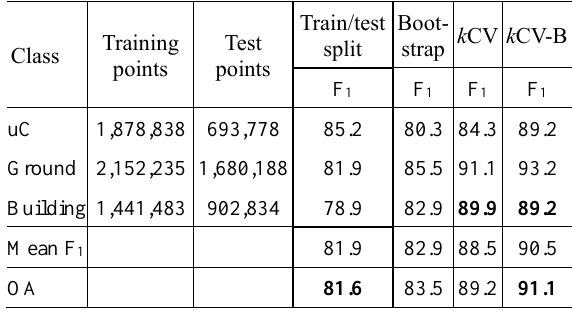
Table 4 . Classification results of AHN test data set. Table 4 contains per class classification performance for the test data set in terms of F 1 -score, Mean F 1 (MF 1 ) and OA. For all the classes k CV-B achieves better OA than the others. The one exception was for buildings, where k CV achieved 89.9% versus 89.2% for k CV-B. In all other instances and in overall F 1 -scores k CV-B outperformed the other methods.